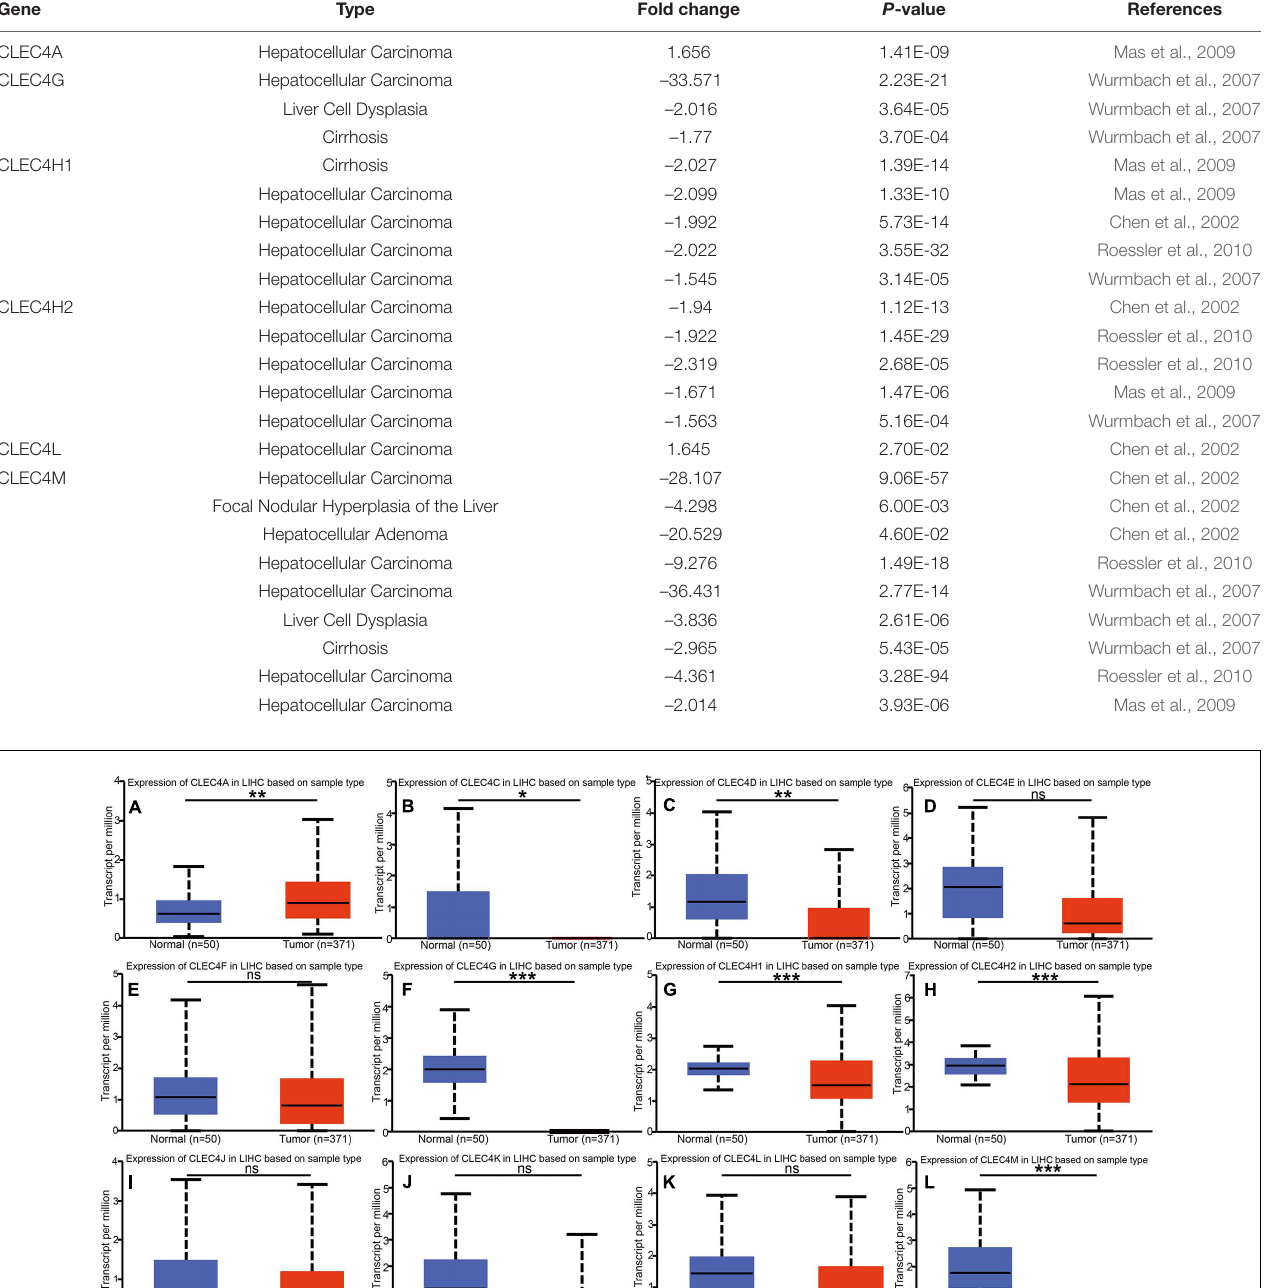
TABLE 1 | The mRNA levels of CLEC4s family in different types of LIHC tissues and normal liver tissues at transcriptional level (ONCOMINE).